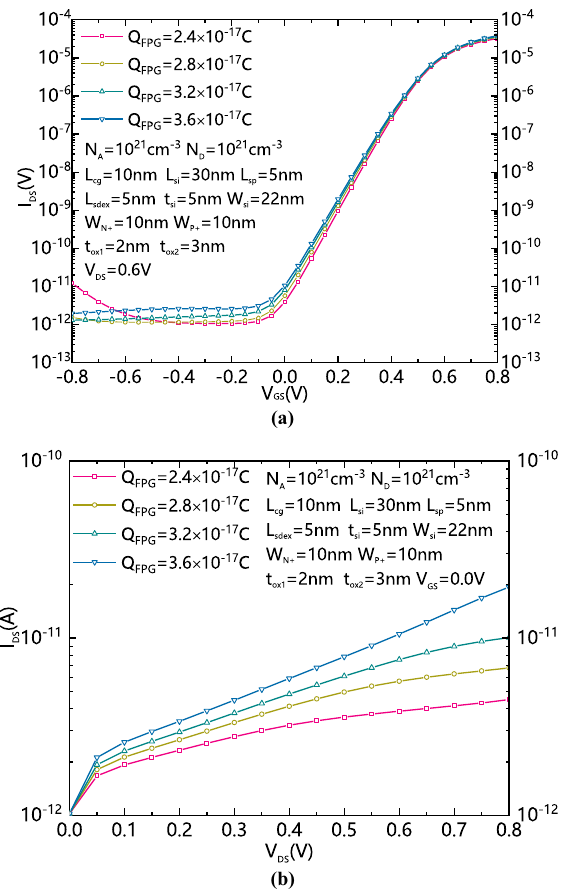
Figure 5. ( a ) Comparison of transfer characteristic of DDN R-FET with different QFPGs and VDS equals to 0.6 V. ( b ) Comparison of standby leakage current of DDN R-FET with different QFPGs and